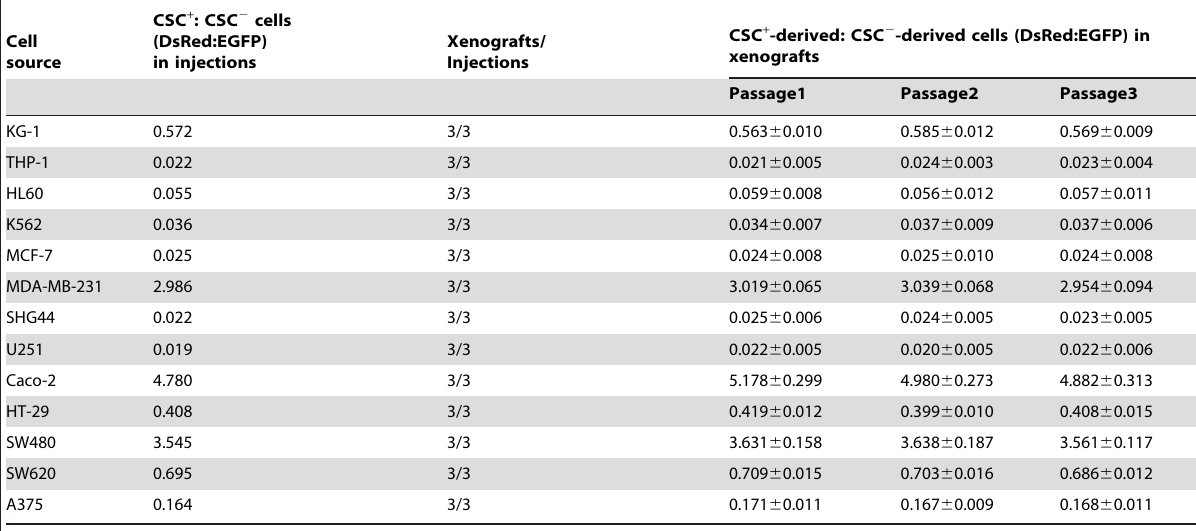
Table 1. Tumorigenesis analysis of co-transplanted CSC + and CSC 2 tumor cells.